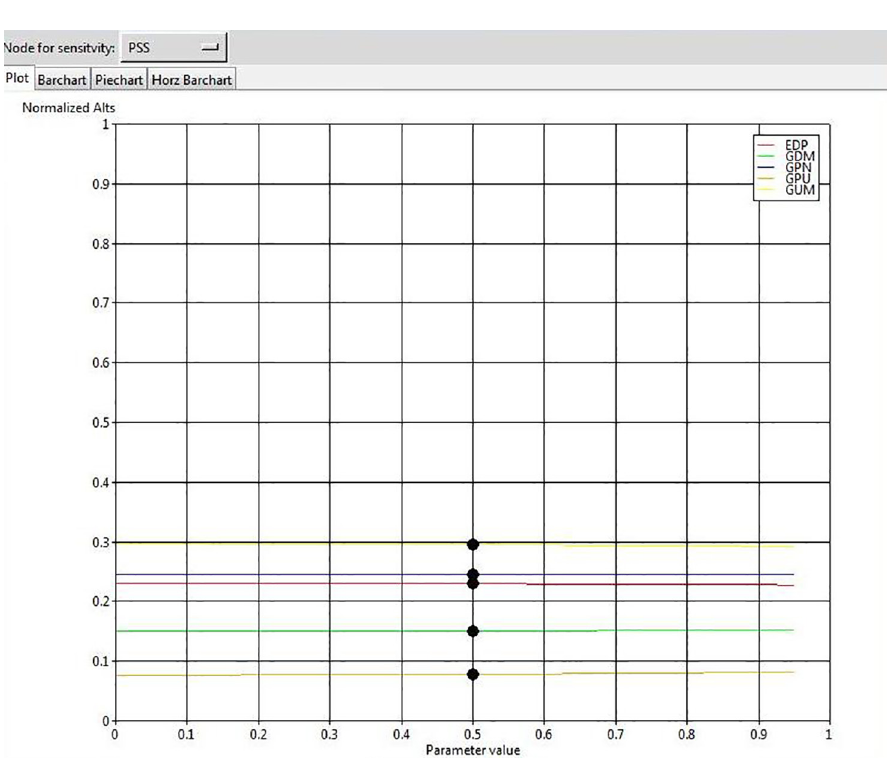
Fig 7. The results of sensitivity analysis for the node “ Product Stewardship ”